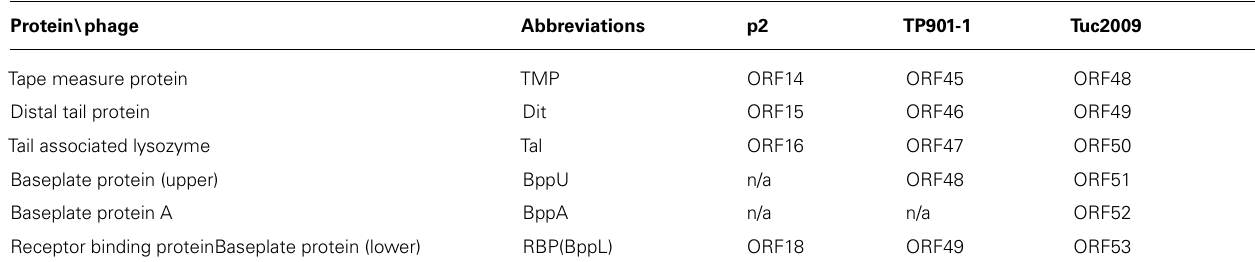
Table 1 | List of the components of the baseplates from lactococcal phages mentioned in this review.